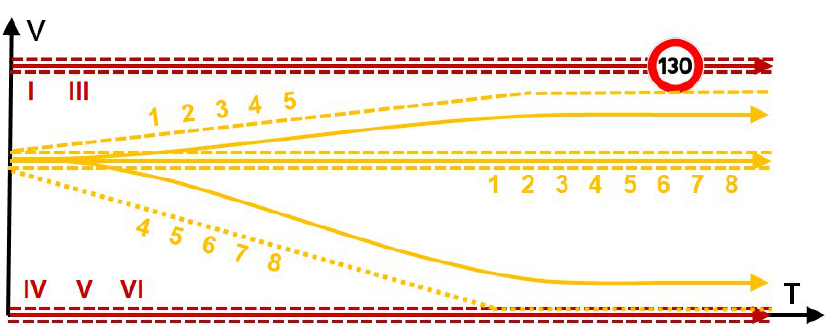
Figure A4. Prediction of ghost trajectories (I–VI) as a function of the ego-vehicle current position including the minimum and maximum trajectory zones.